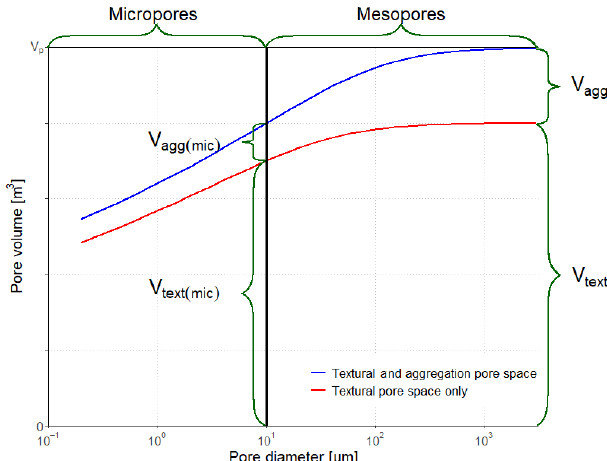
Figure 2. Schematic illustration of pore volumes and pore classes in the model (for explanation of symbols, see text). In this exam- ple, macroporosity has been neglected, and the total pore space is comprised of 80% textural pores and 20% aggregation pores in- duced by soil organic matter, with a maximum micropore diameter of